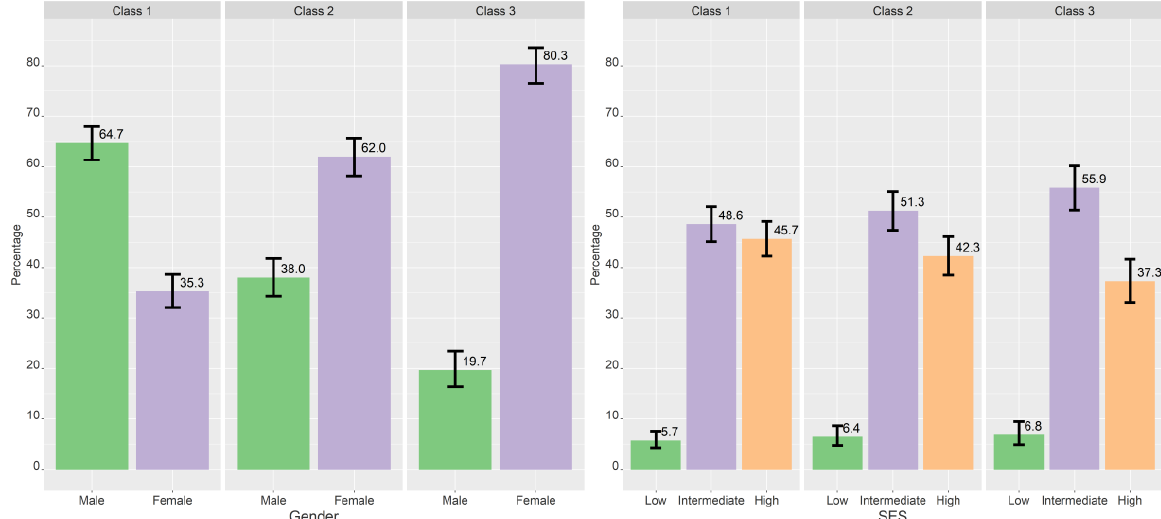
Figure 3. Crude proportions for each class across gender, age, and subjective socioeconomic status. Proportions based on most probable class belongingness. The error bars denote 95% confidence